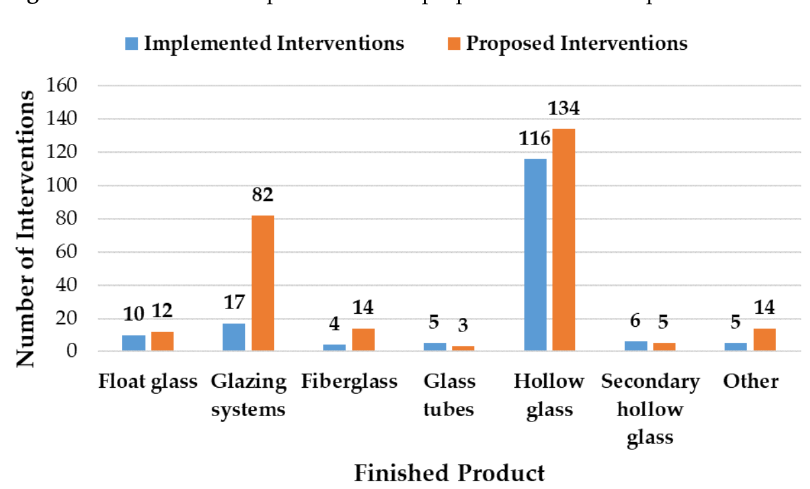
Figure 6. Interventions implemented and proposed according to different product